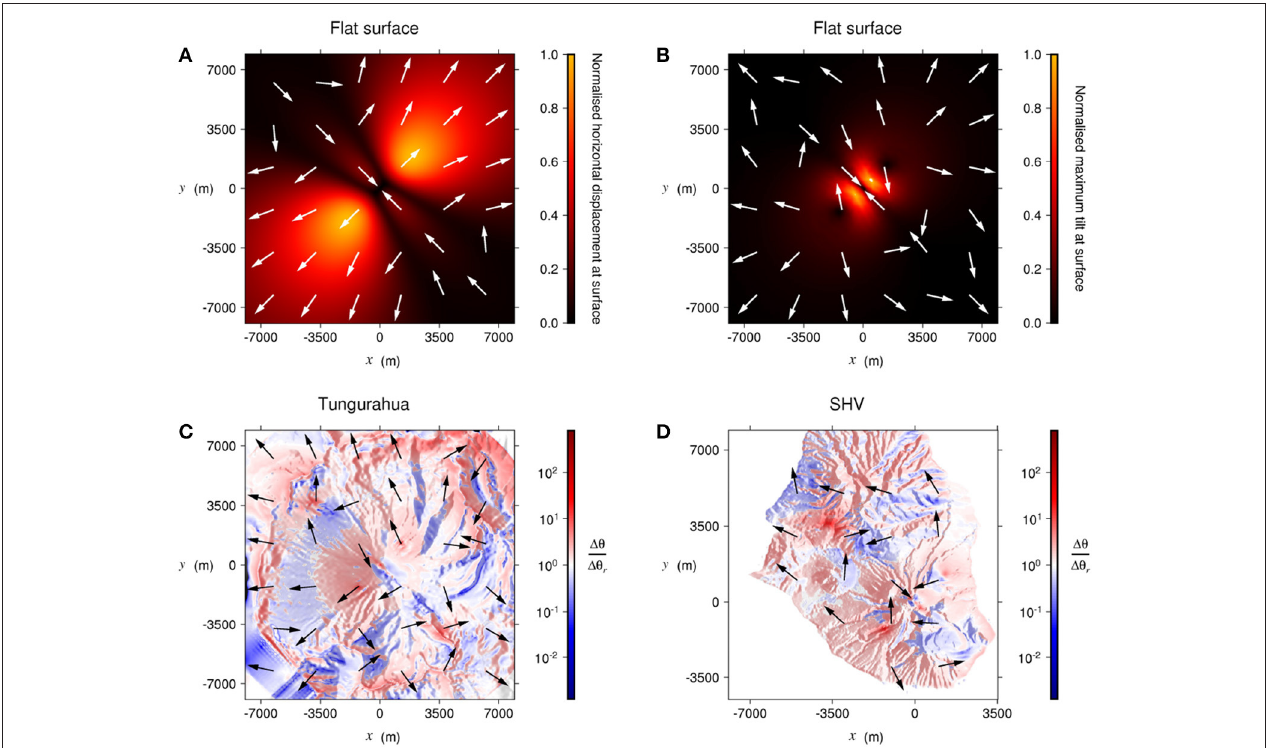
FIGURE 10 | Deformation produced by the pressurization of a NW-SE striking dyke. (A) Normalized amplitude and orientation of the displacement field for a dyke 1.2 km below a flat surface, (B) Normalized amplitude and orientation of the maximum tilt for the same dyke below a flat surface. (C) Amplification factor due to the topographic effect on tilt for the same dyke 1.2 km below the summit of Tungurahua and (D) SHV. The dyke is located at x = 0 m, y = 0 m in each case.